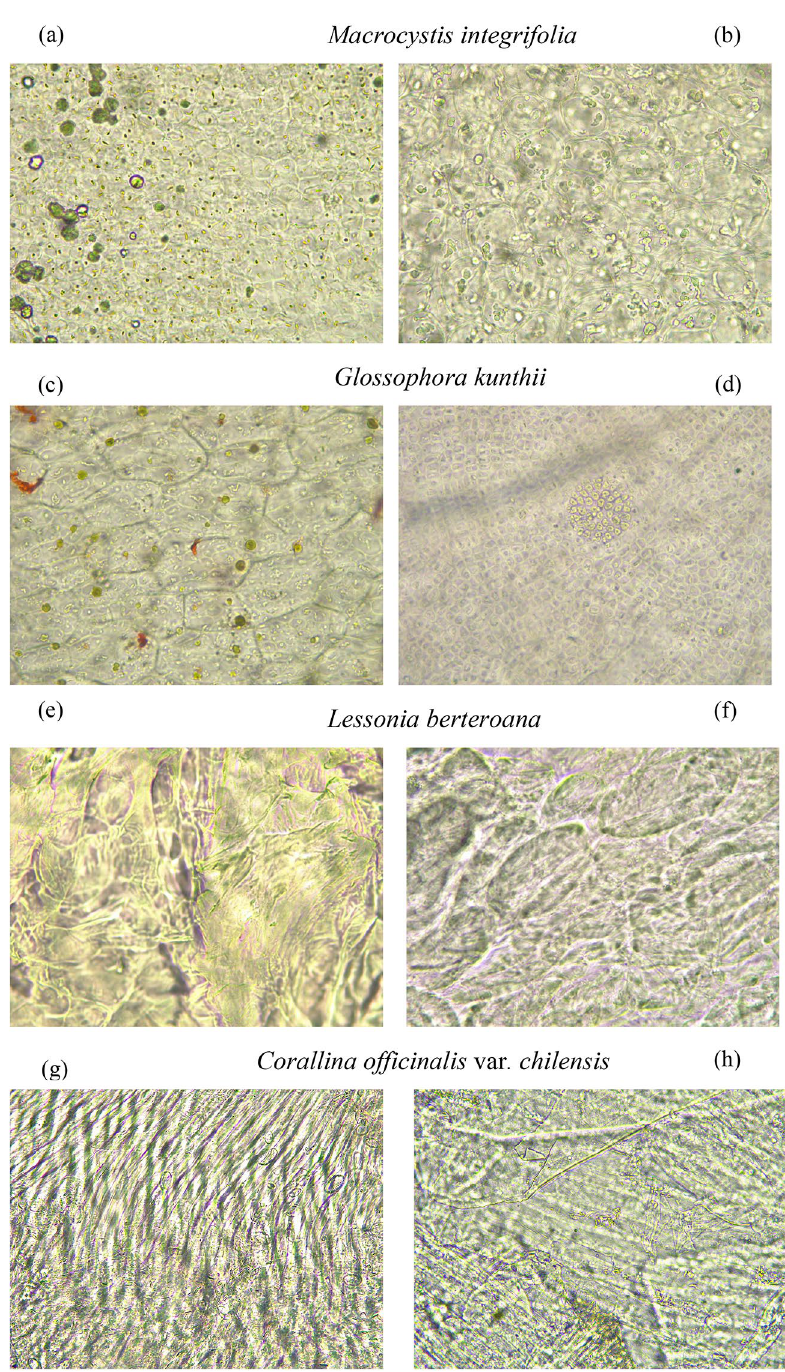
Figure 1. Photomicrographs (×40 magnification) of macroalgae from stomach contents of individuals of Medialuna ancietae prepared with sodium bicarbonate method ( a ), ( c ), ( e ), and ( g ) compared to reference